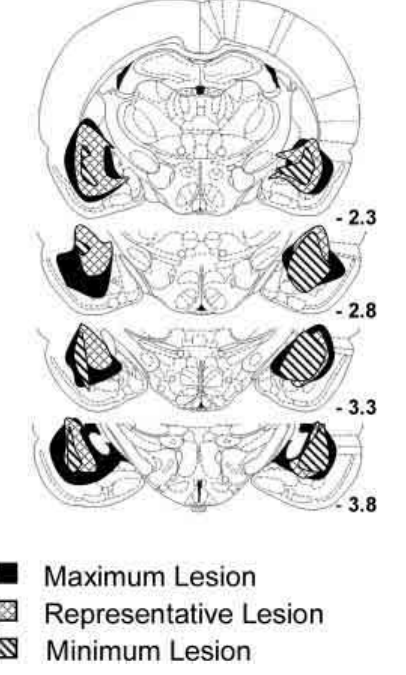
Figure 5. The extent of amygdala lesions . Lesions encompassed >75% of the basolateral complex bilaterally. In addition, most lesions also affected rostral central nucleus of the amygdala.